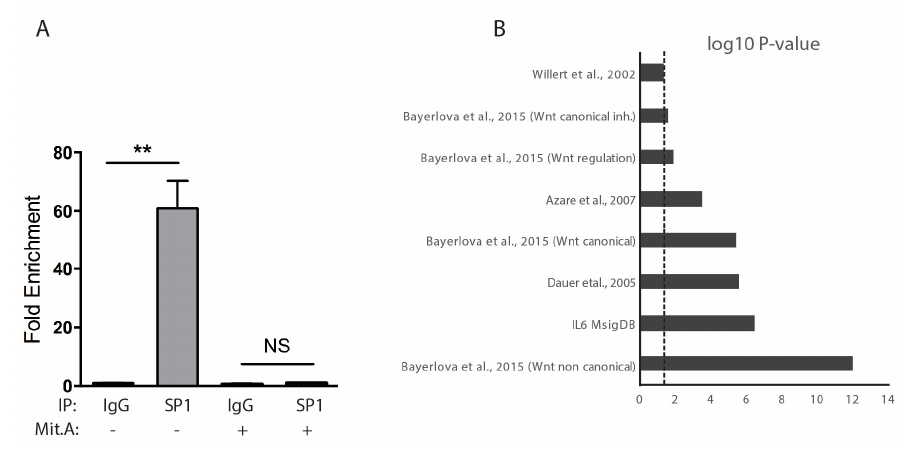
Figure 5. Cont. Figure 5.